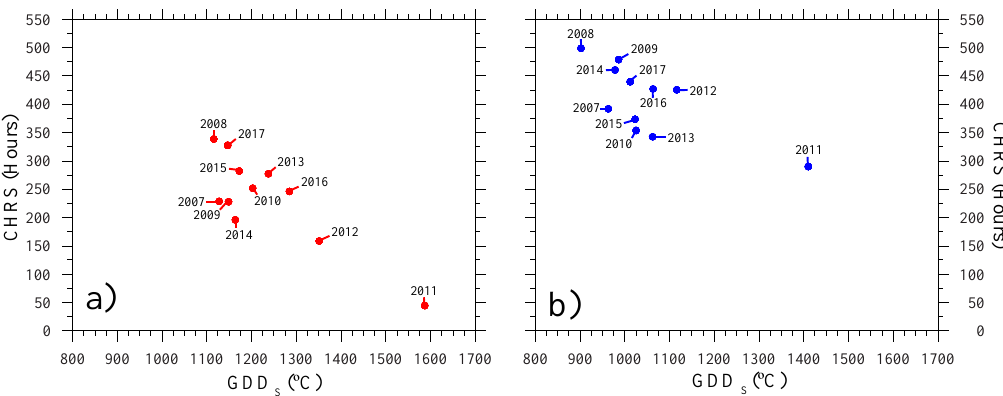
Figure 2. ( a ) Scatterplot of May-planted GDD S (X-axis) vs. May-planted CHRS (Y-axis) derived from the Abernathy mesonet station data during 2007 – 2017. ( b ) As in (a) for June-planted GDD S vs. June-planted CHRS.